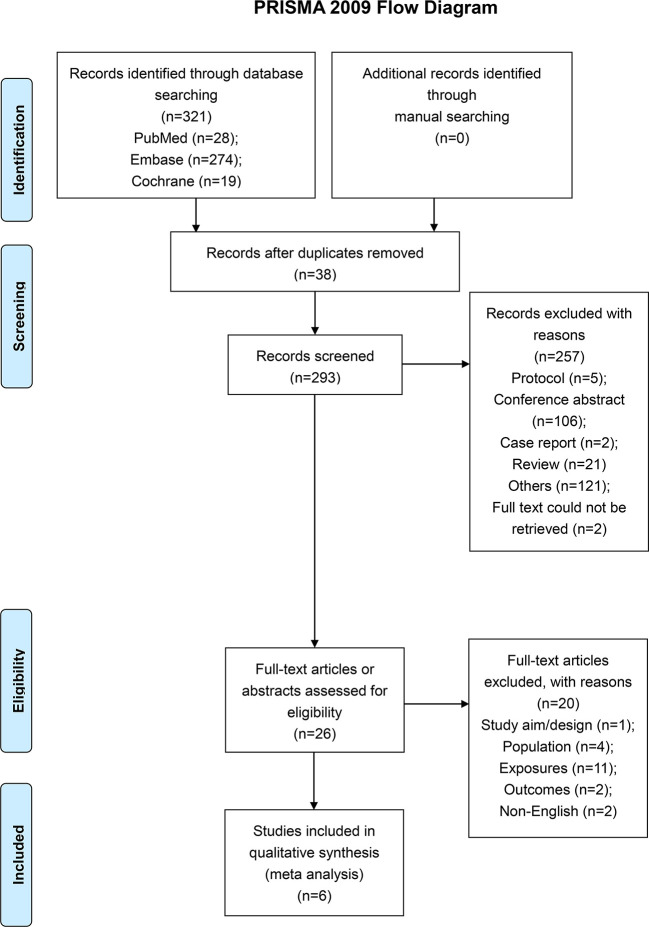
Study flowchart.